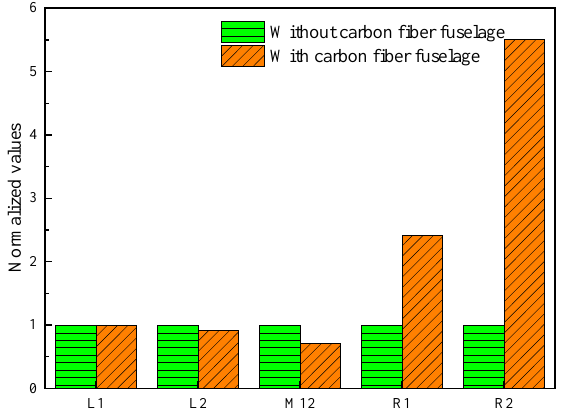
Figure 4. Variation in the mutual inductance, self-inductance, and resistance.